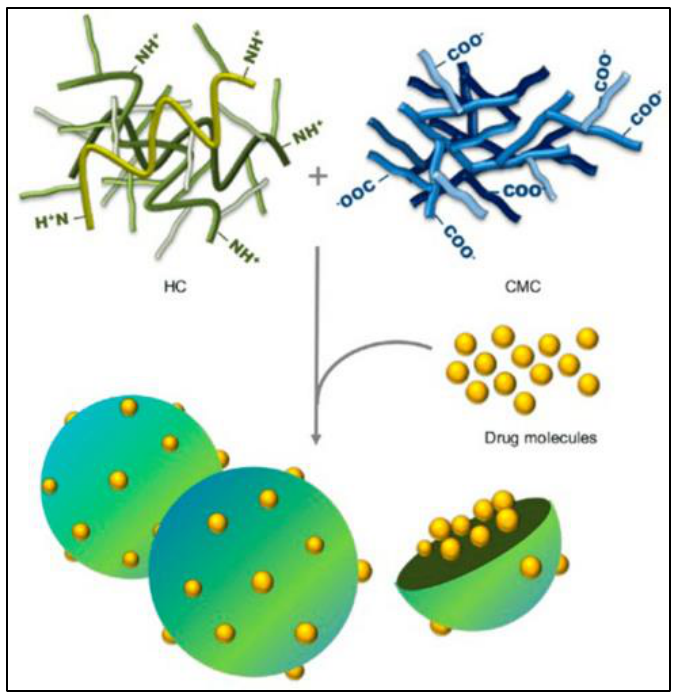
Figure 8. Self-assembled colloids from BCP. Schematic representation of nanostructured colloids enabled by BCP for use in drug delivery applications. Reproduced with permission from the original article [224].